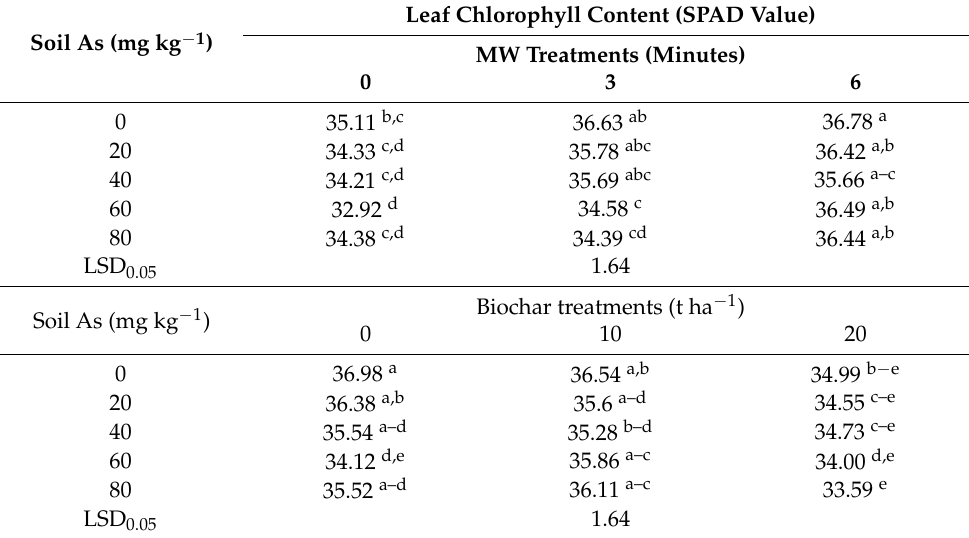
Values having different superscript letters indicate significant differences among the treatments. Least significant differ- ence (LSD) test was performed at 5% level of significance to determine the difference between the treatments.